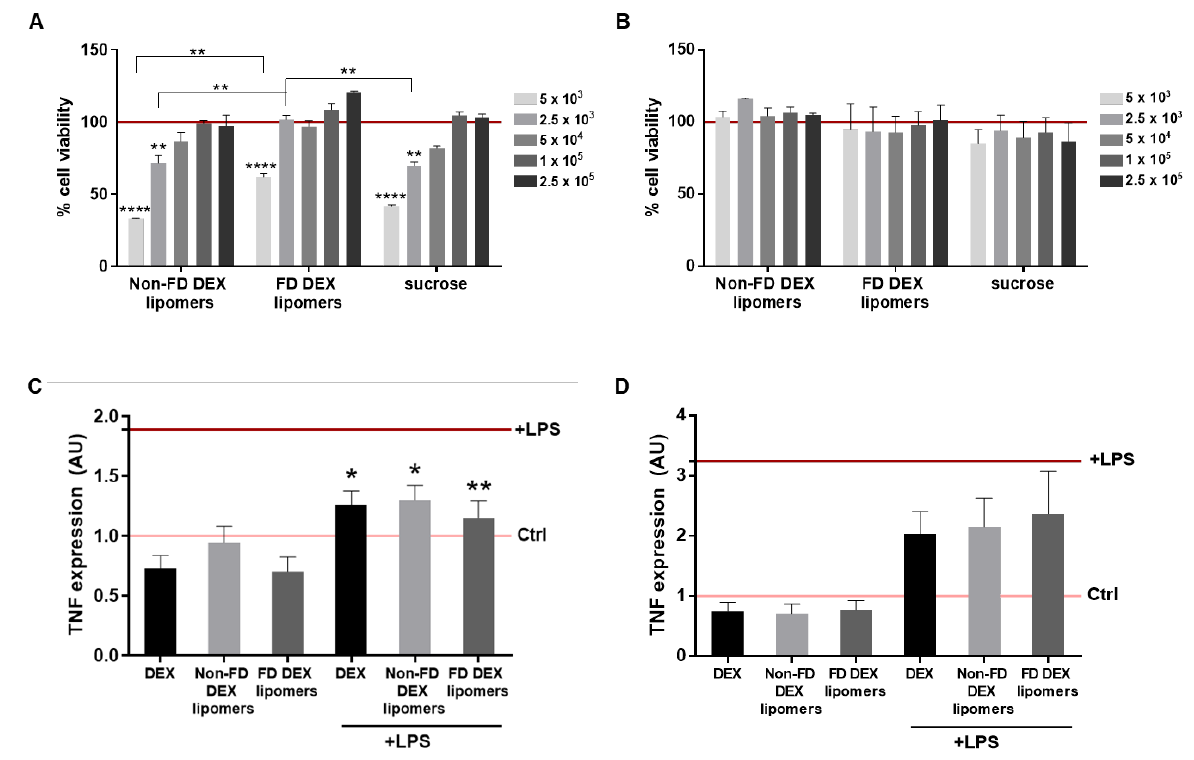
Figure 9. Cytotoxicity and anti-TNF α efficacy studies in HEK001 ( A , C ) and HaCaT cells ( B , D ). ( A , B ) Cell viability analyzed by MTT. The indicated numbers represent the inverse dilution factors, referring to the synthetized lipomers. Dilution factors for DEX-loaded lipomers correspond to concentrations of 5, 1, 0.5, 0.25, and 0.1 µ M of DEX. Data are represented as the mean ± SEM ( n = 3) of the cell viability percentage, referring to untreated controls (horizontal lane). Statistical significance was assessed by two-way ANOVA ** p < 0.01; **** p < 0.001. ( C , D ) TNF α mRNA expression was determined after a 24 h treatment of free DEX 0.1 µ M (black), non-FD DEX-lipomers (gray), or FD DEX-lipomers (dark gray), without ( left ) or with ( right ) a 1 h pretreatment with LPS (10 µ g/mL). TNF α expression is represented as the mean ± SEM ( n = 4 HEK001; n = 3 HaCaT); horizontal pink and red lanes represent TNF α expression under control and LPS conditions, respectively. Statistical significance was evaluated by one-way ANOVA compared to LPS; * p < 0.05, ** p <